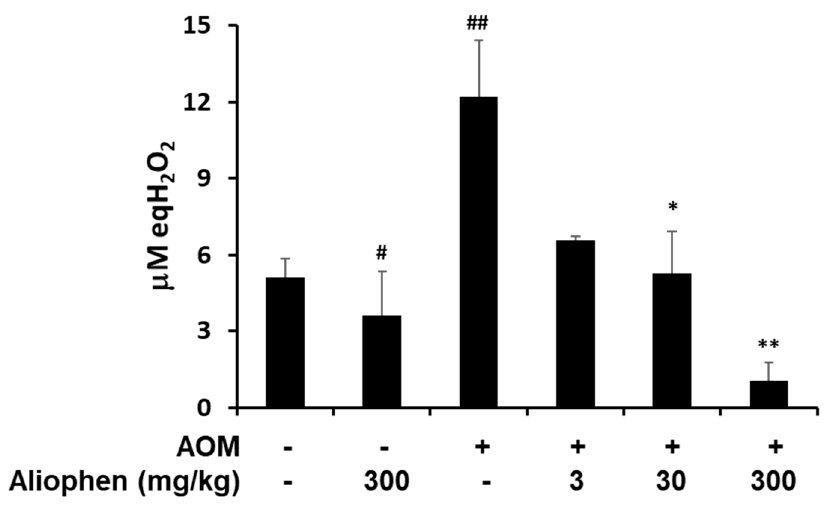
Figure 6. D-Aliophen ® reduces the oxidative stress in the serum of azoxymethane (AOM) treated mice Peroxides assay (express as equivalents of H 2 O 2 ) in serum samples from mice treated with D-Aliophen ® (3–300 mg/kg) in the presence/absence of AOM. The samples derived from animals sacrificed at the end of the experiment. Bar graphs represent the mean ± SEM. Symbols indicate significance: # p < 0.01, ## p < 0.005 vs. untreated, * p < 0.05, ** p < 0.005 vs. AOM.